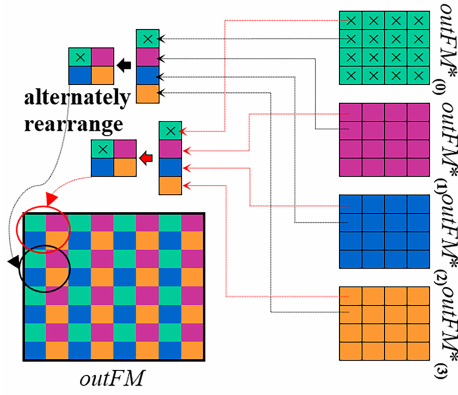
Figure 6. The data REARRANGEMENT process.